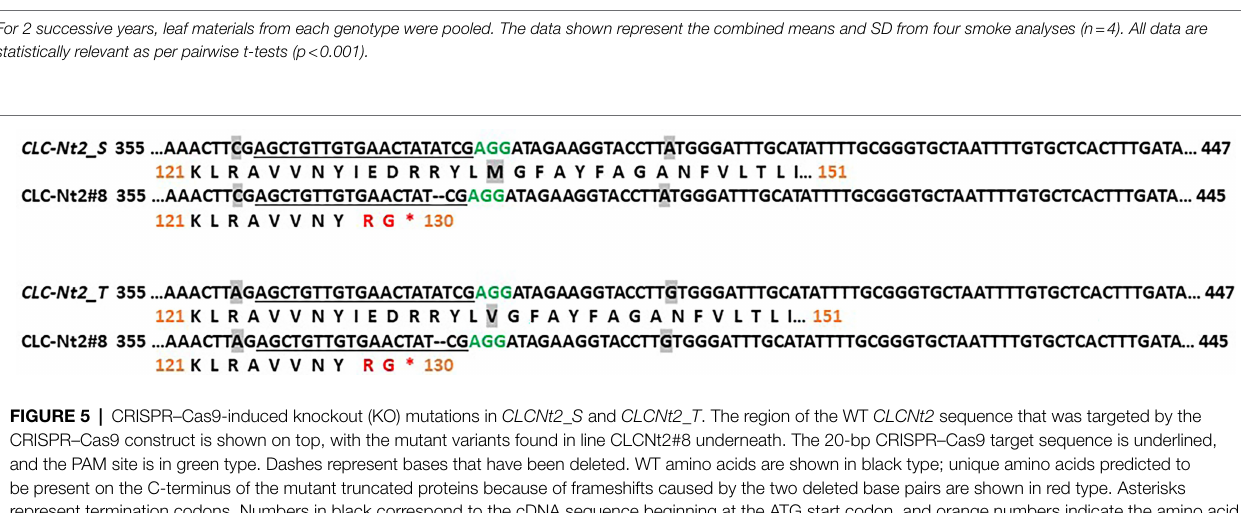
For 2 successive years, leaf materials from each genotype were pooled. The data shown represent the combined means and SD from four smoke analyses (n = 4). All data are statistically relevant as per pairwise t-tests (p < 0.001).